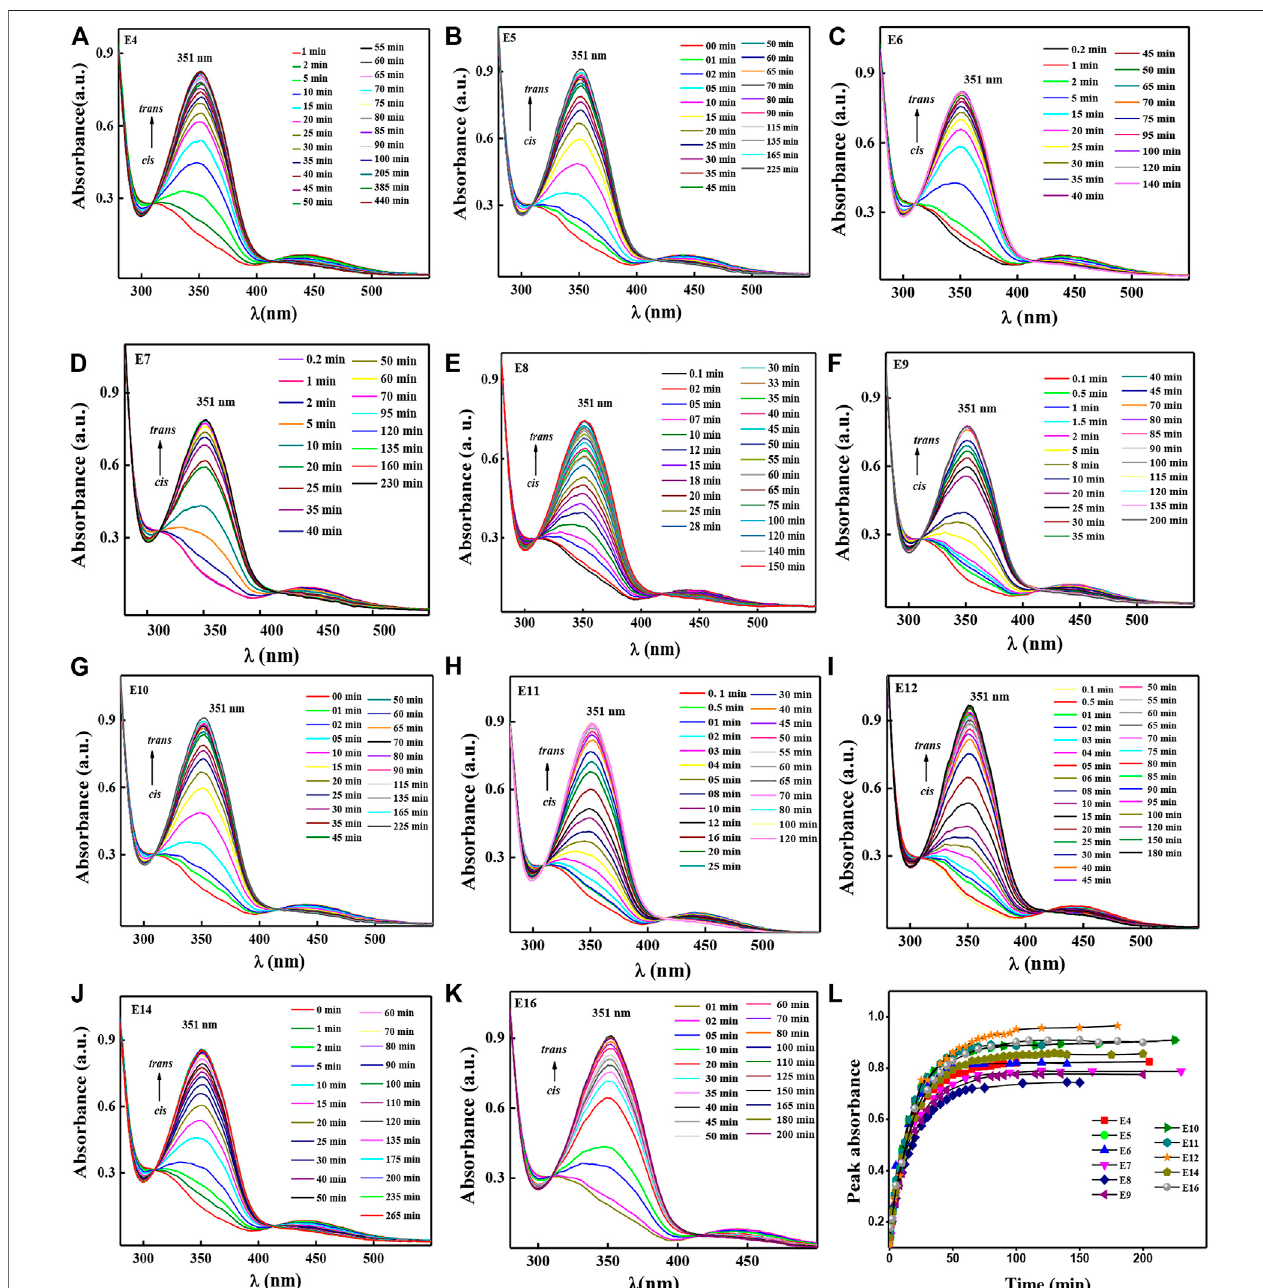
FIGURE 4 | Thermal back relaxation data for the compounds E4-E16, as represented as Panel 4A – K. Peak absorbance as a function of thermal back relaxation time for all HSLCs were given in Panel 4L.